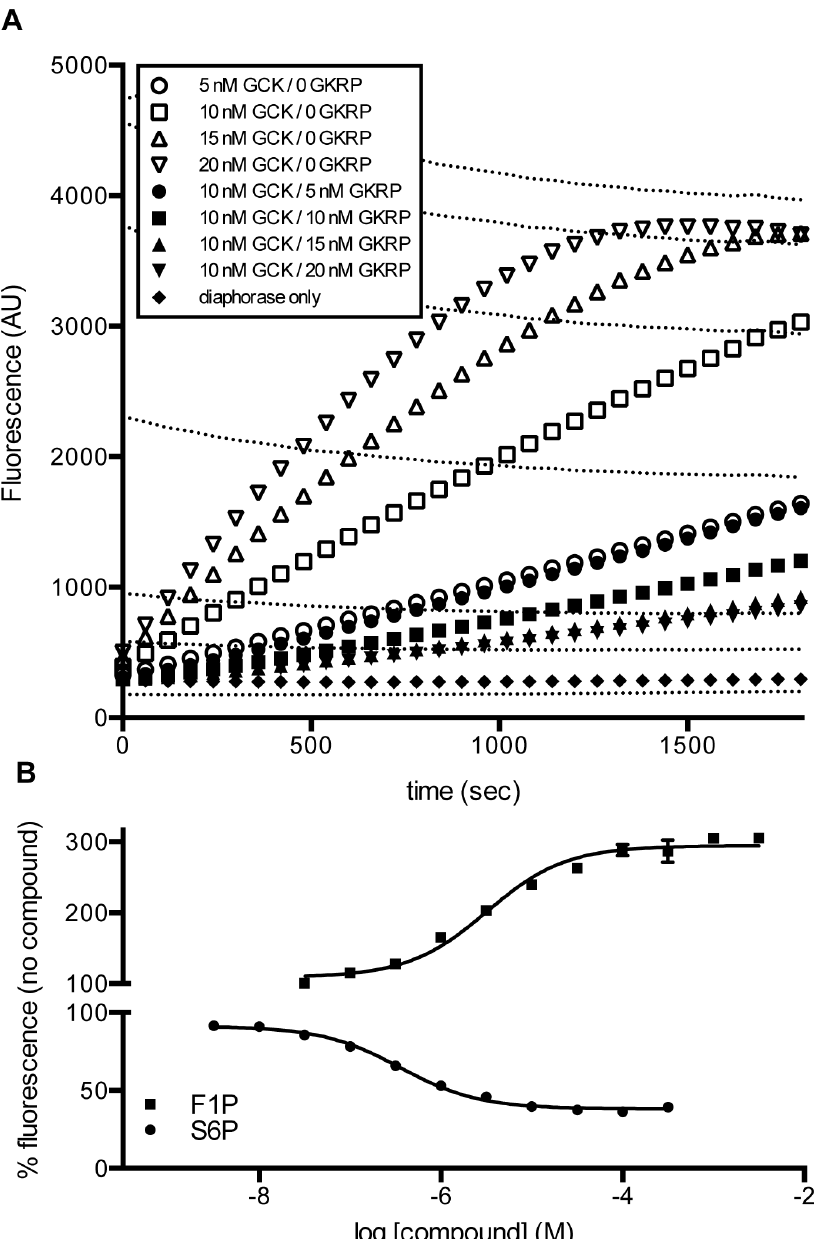
Figure 4. Optimization and validation of diaphorase-coupled detection of the GCK enzymatic reaction. (A) Reaction progress of the dual-coupled diaphorase reaction at various GCK and GKRP concentrations. Each data point is mean 6 SEM for n=8. Dashed lines are NADP + /NADPH controls, with the %NADPH increasing from the bottom (0%) to the top (100%) dashed line. (B) Effect of GKRP modulators on the dual-coupled diaphorase reaction. The reaction included 10 nM GCK and 10 nM GKRP. Results are shown for t=10 minutes. Each data point is mean 6 SEM for n=2–4.